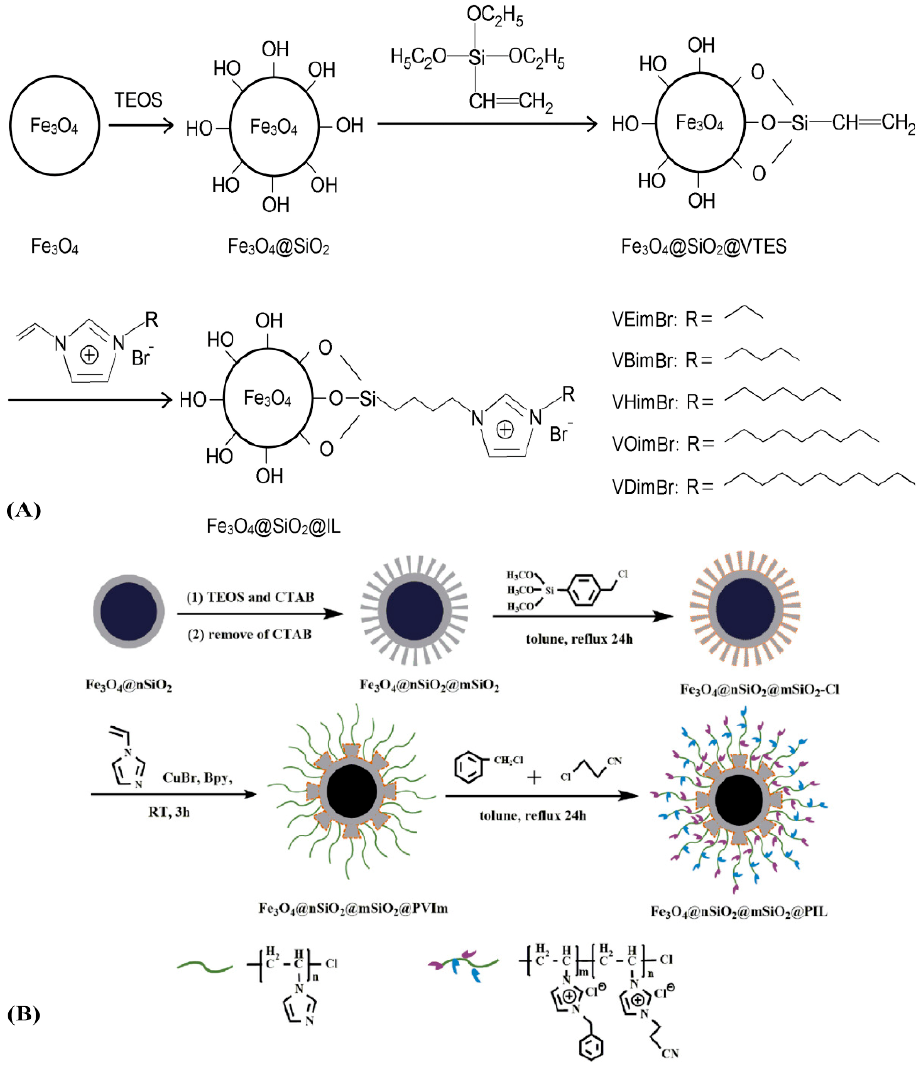
Figure 3. ( A ) Preparation procedure of Fe 3 O 4 @SiO 2 @IL particles. Republished from Ref. [45], Copyright (2020), with permission from Elsevier. ( B ) Synthesis of PILs@mSiO 2 @nSiO 2 @Fe 3 O 4 . Republished from Ref. [46], Copyright (2019), with permission from